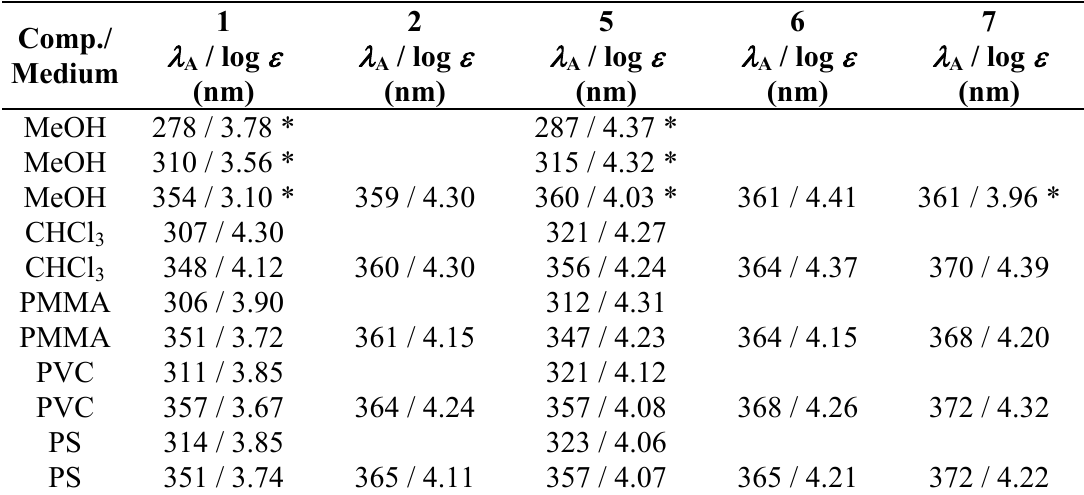
Table 1. Spectral data on UV absorption spectra of 1 , 2 , 5 , 6 and 7 .